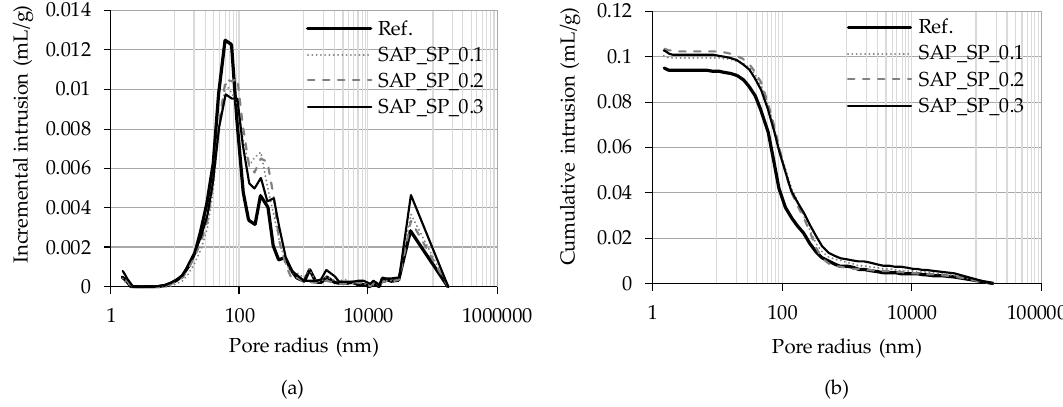
Figure 4. Pore size distribution of the mortar samples. ( a ) Incremental intrusion and ( b ) cumulative intrusion according to pore radius.